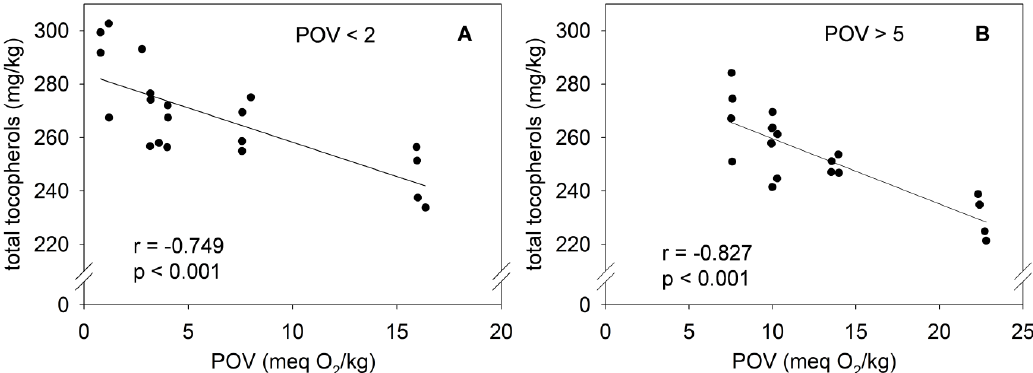
Figure 4. Correlation between the POV and the tocopherol content in mildly ( A ) and highly ( B ) oxidized palm oil stored under household-representative conditions in the presence of RP for 57 days.